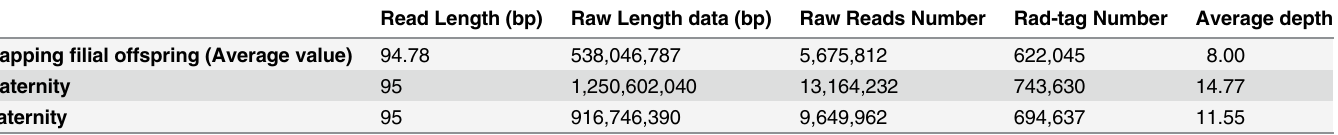
Table 1. S . maximus RAD sequencing results.